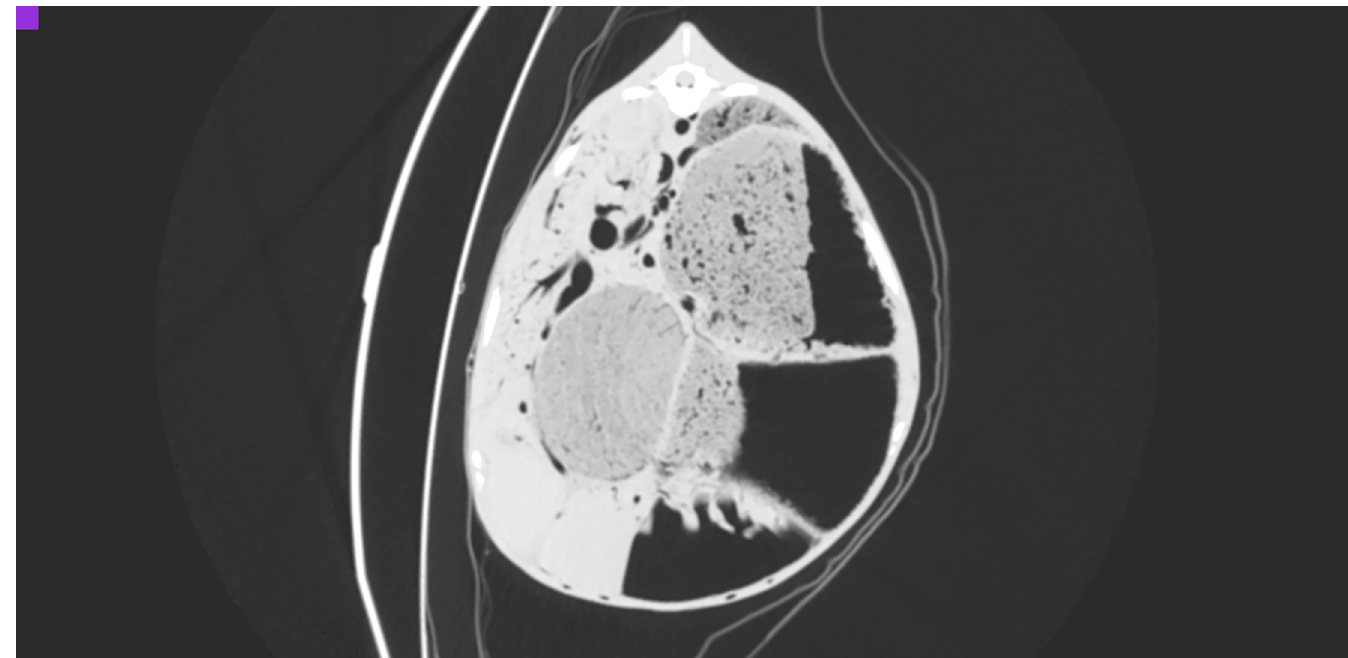
Fig 6. CT reconstruction in transverse plane at the level of the 12th thoracic vertebra after intra-arterial air inflation; lung window. Air-filled blood vessels visible, among others aorta, vena cava, portal vein, splenic veins, hepatic veins.